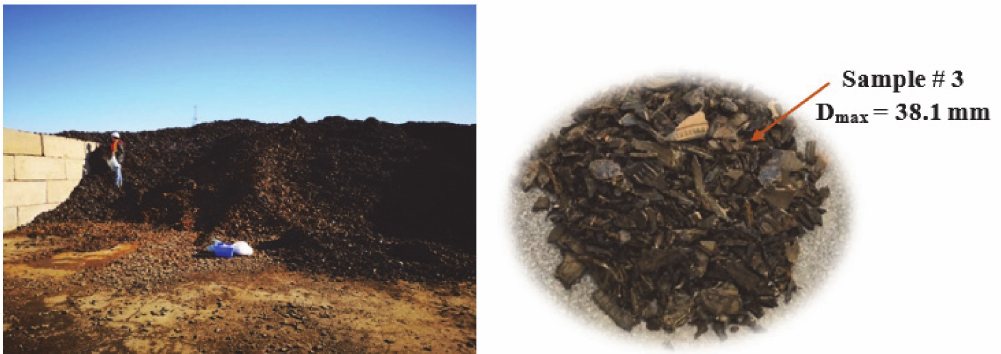
Figure 1. TDA from Halifax C&D Recycling Ltd.